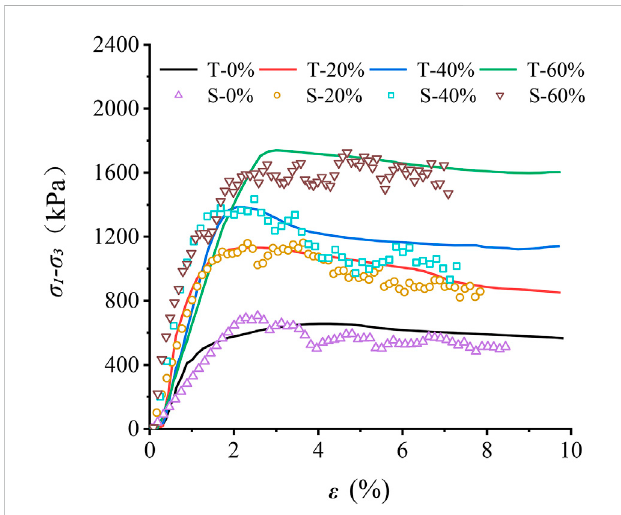
FIGURE 8 The deviator stress-strain curves of TSM specimens with four slag contents provided by the standard triaxial tests (T) and numerically simulated triaxial tests